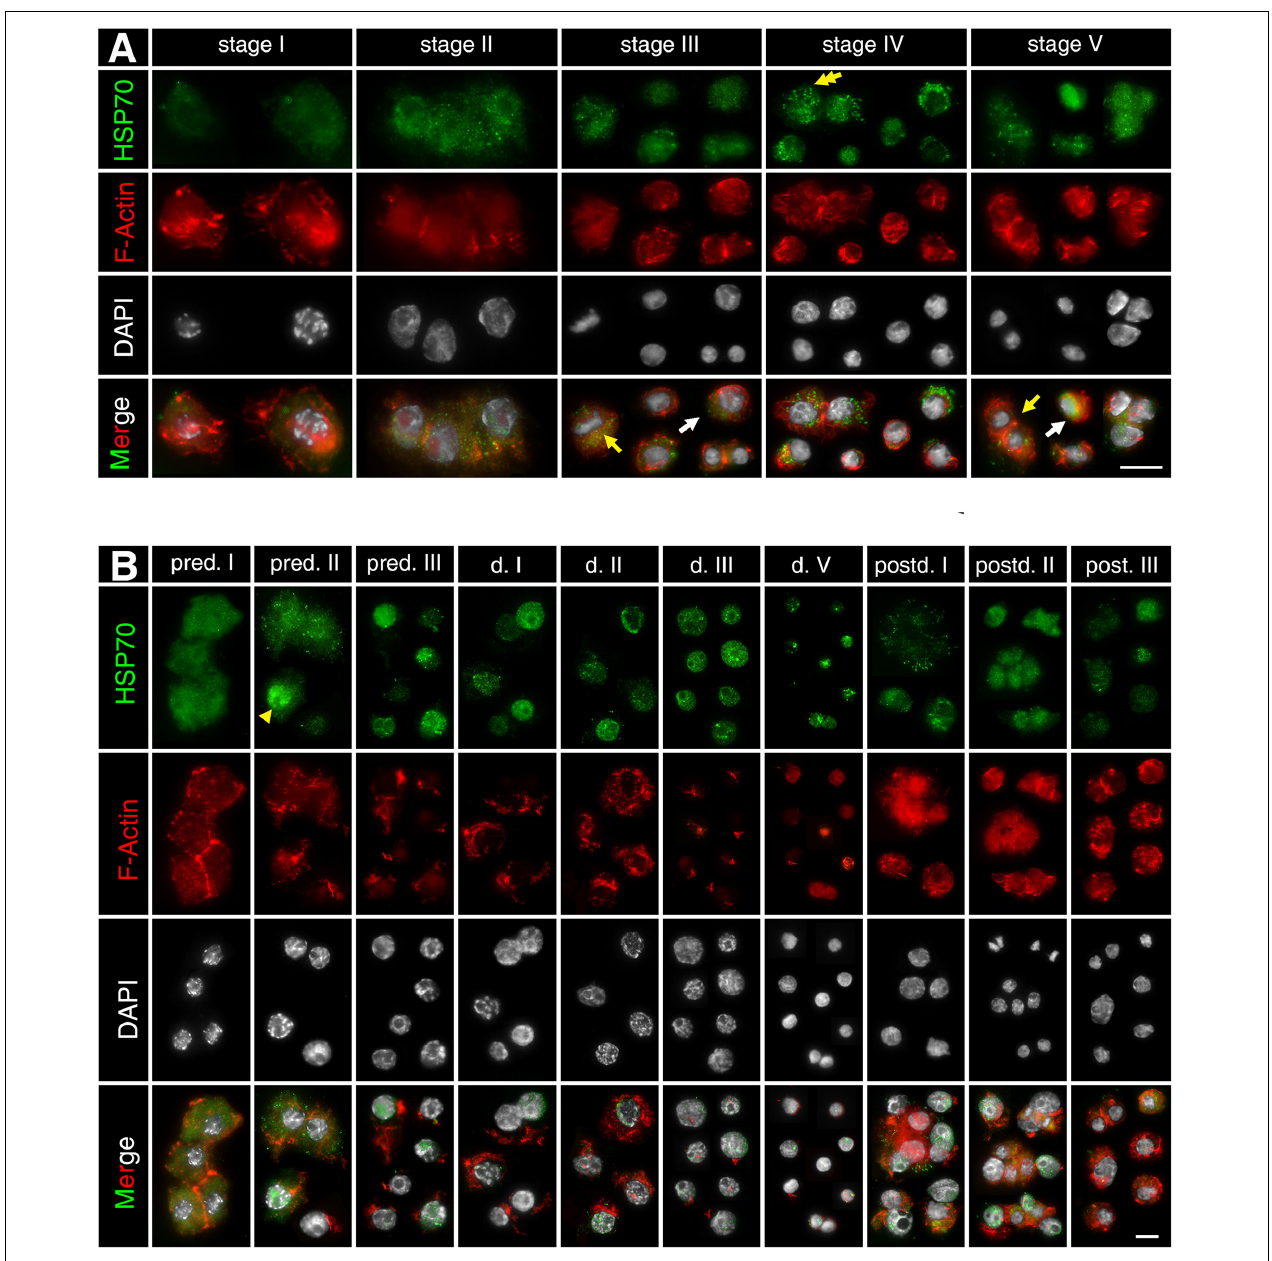
FIGURE 3 | Subcellular localization of HSP70B protein during development of D. magna asexually (A) and sexually (B) produced embryos. Actin filaments were stained with phalloidin in red and chromatin with DAPI in white. (A) In developing asexually produced embryos, HSP70B protein (green) distributed homogeneously throughout cytosol and was found in all embryonic stages. HSP70B signals were found in both interphase cells (white arrow) and M-phase cells (yellow arrow). Protein signals at “stage I” were more homogeneously distributed. From “stage II” onward, HSP70B was detected in a granular-like pattern in most cells (yellow double arrow). (B) During development of diapause destined embryos, fully developed actin microfilament networks were detected, whereas HSP70B started accumulating in nucleus at “pred. II” (yellow arrowhead). Upon “pred. III,” cytosolic HSP70B vanished. During diapause stage, actin microfilament networks began